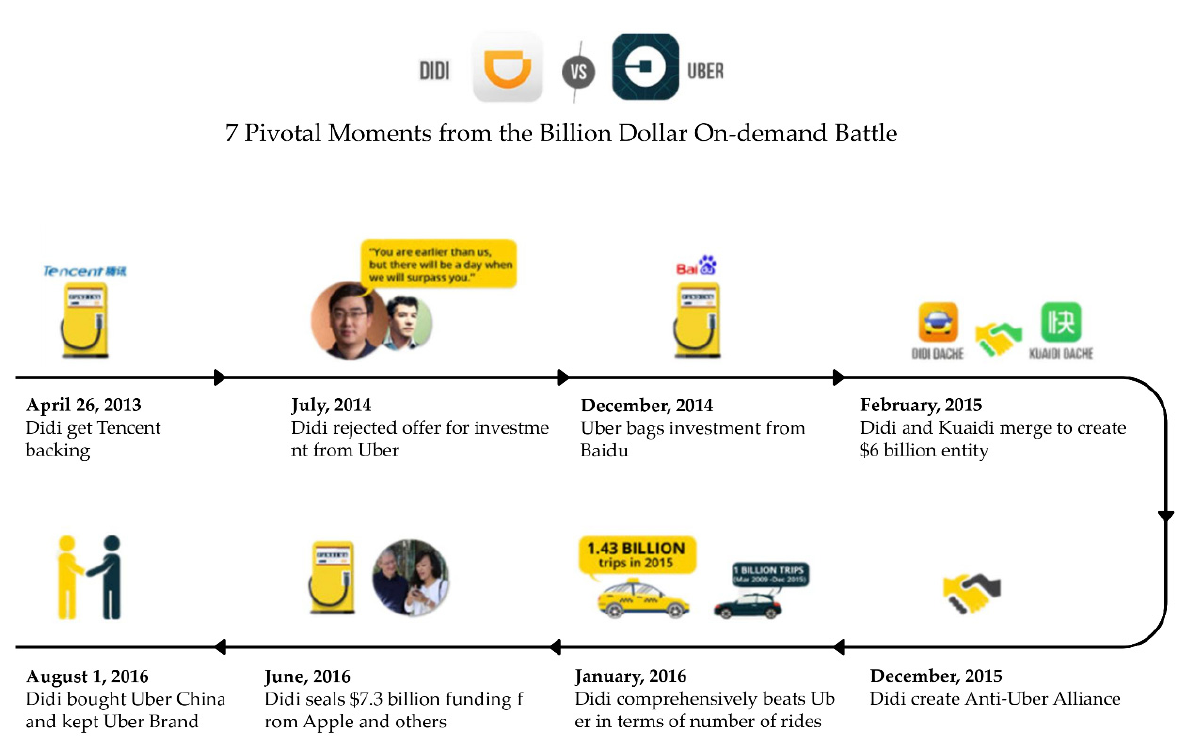
Figure 1. The battle between Uber and DiDi Chuxing [1].